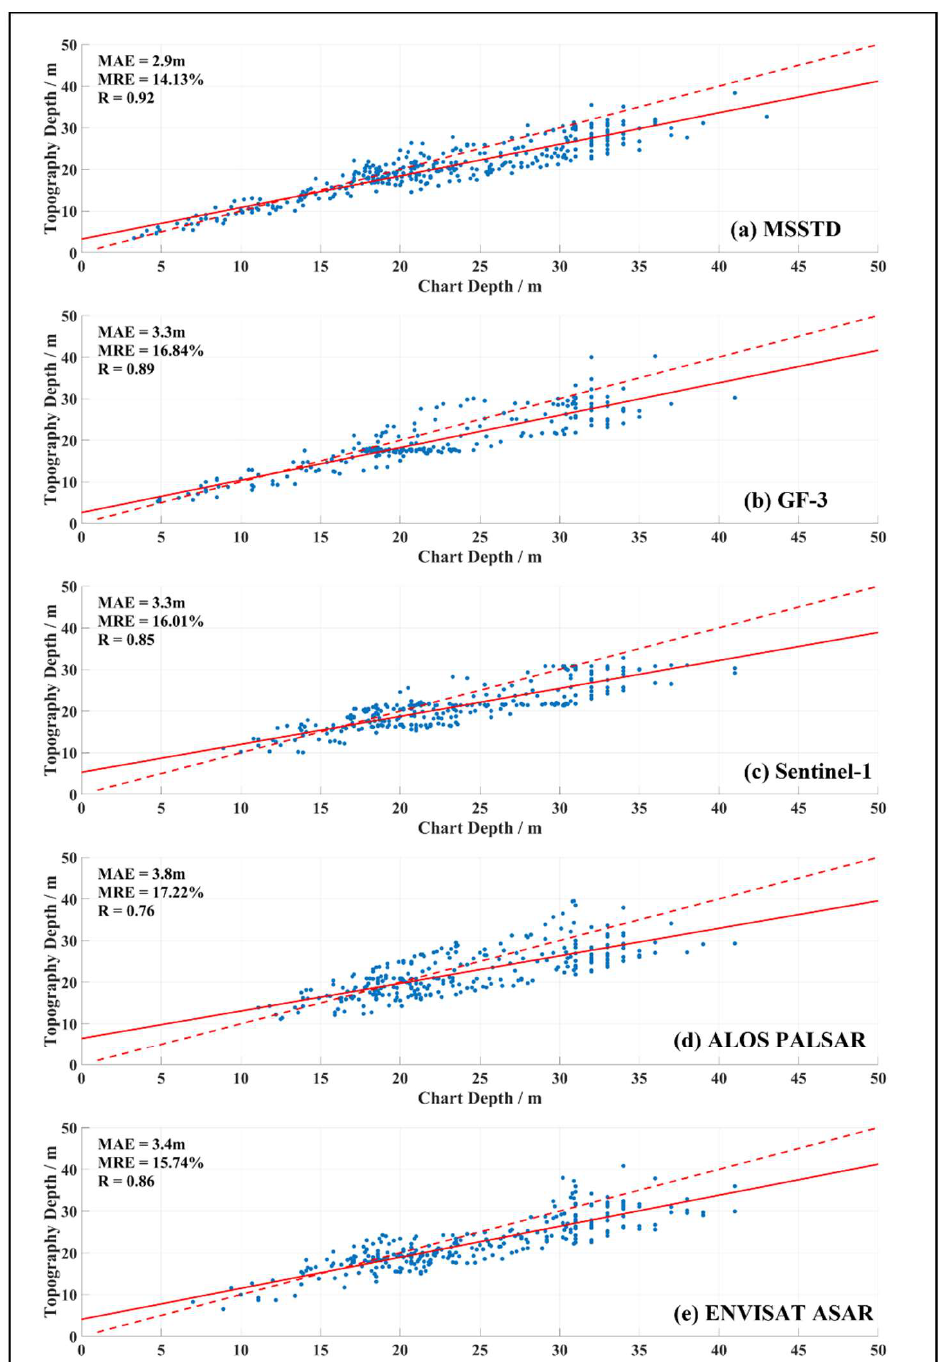
Figure 10. Scatter plots of retrieved topography and chart data. The red dash line is the 1:1 line and red solid line is the linear fit line. The index R is the linear correlation coefficient.